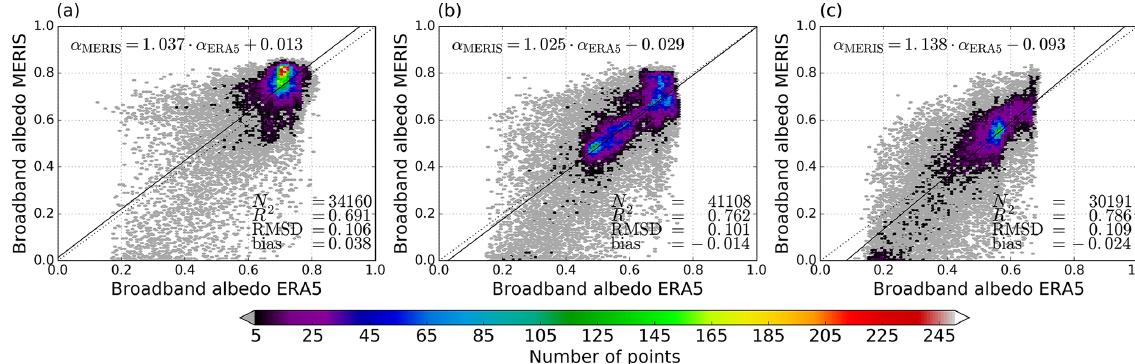
Figure 7. Comparison of ERA5- and MERIS-derived grid cell broadband albedo of Arctic sea ice on selected days of Fig. 6; (a) 2 June 2007, before melt onset; (b) 12 June 2007, at melt onset; and (c) 25 June 2007, after melt onset. The regression line and one-to-one line are shown as solid black and dotted black lines,